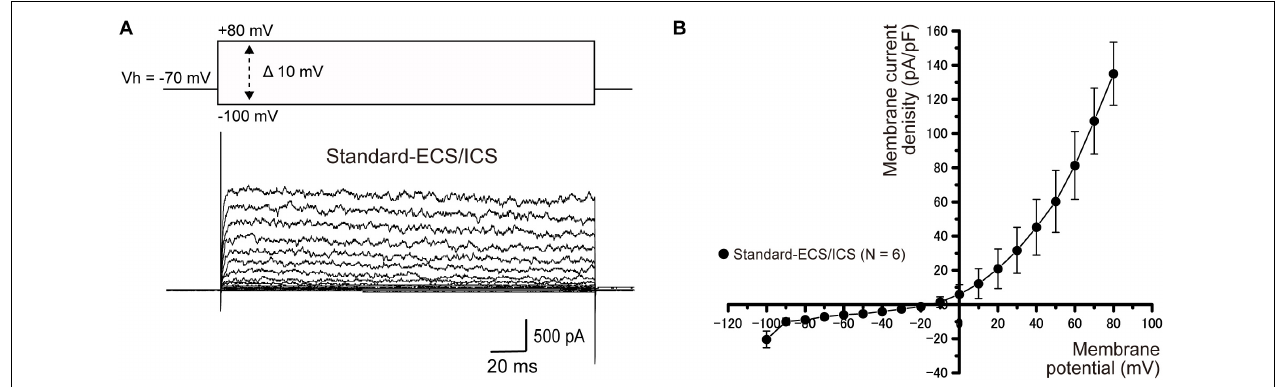
FIGURE 1 | Outward currents under the standard-ECS/ICS. (A) Using the standard-ECS/ICS, the application of pulses of voltage in steps that ranged from –100 mV to +80 mV at 10 mV increments, with a holding potential (Vh) of –70 mV (400 ms in duration; upper traces) evoked outward currents (lower traces). (B) Current-voltage (I-V) relationships of the outward currents are shown. The horizontal axis indicates the membrane potential applied and the vertical axis represents the current density. I-V curves were obtained by plotting the values of the peak current amplitude as densities against the applied membrane potentials. Each point represents the mean ± SE current density of six cells.